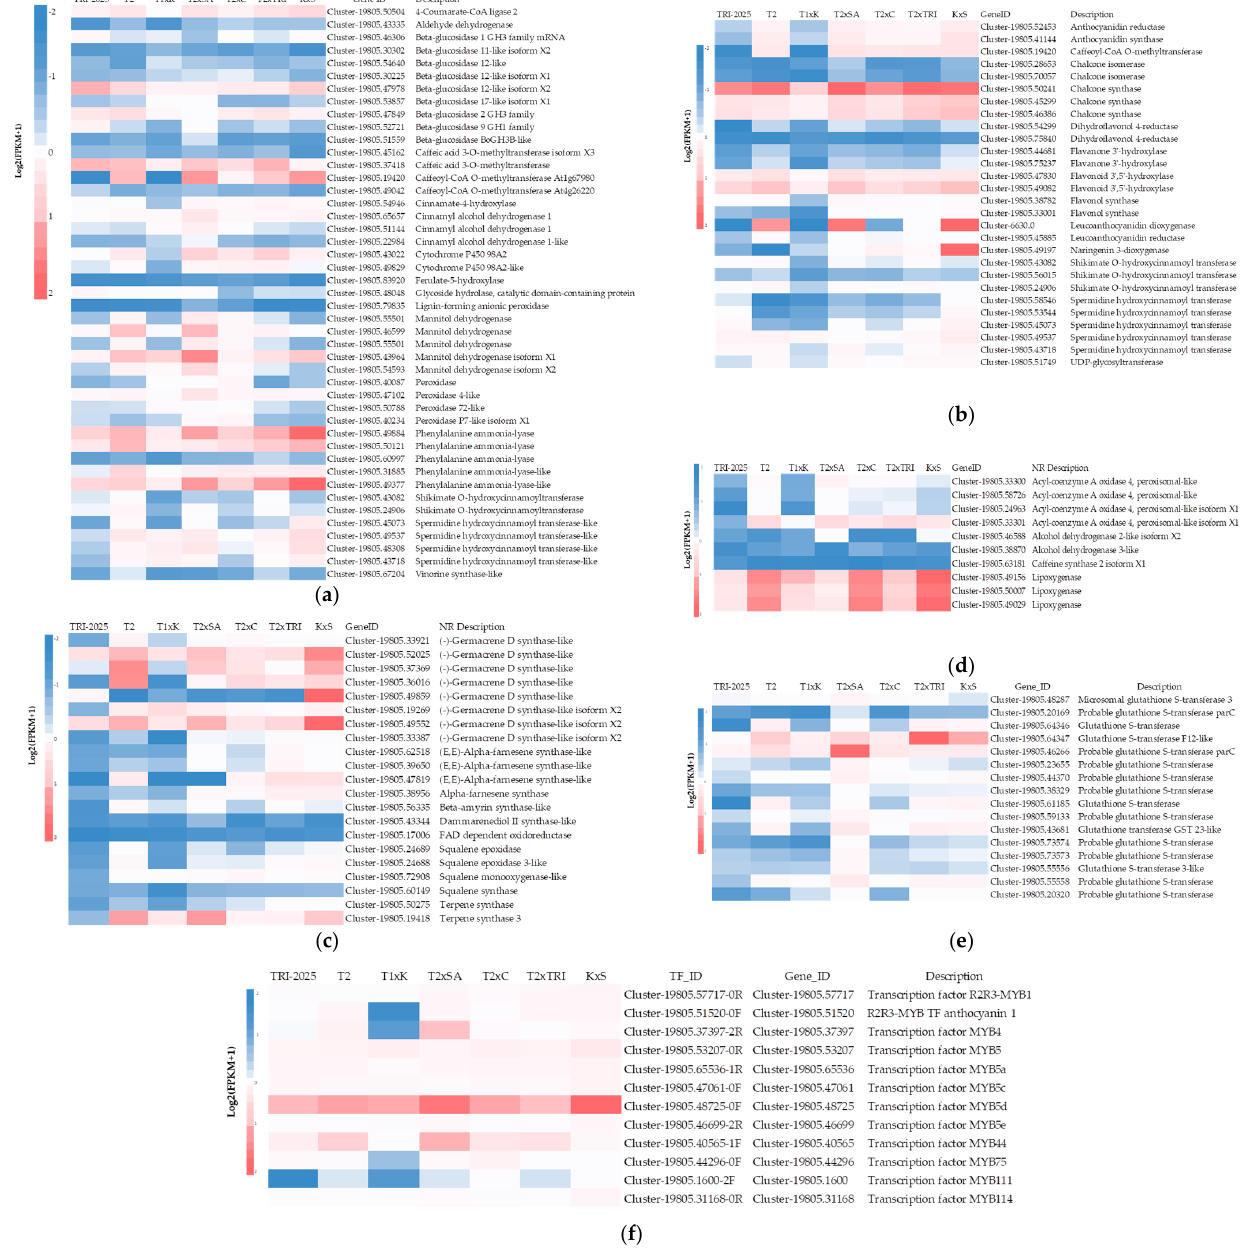
Figure 7. DEG enrichment analysis of each gene involved in biosynthesis and metabolism pathway that was associated with tea quality. ( a ) Phenylpropanoid biosynthesis; ( b ) flavonoid biosynthesis; ( c ) sesquiterpenoid and triterpenoid biosynthesis; ( d ) alpha-linolenic acid biosynthesis; ( e ) drug metabolism-cytochrome P450; ( f ) MYB TF. sized through a specific branch of a phenylpropanoid pathway [21]. Highly expressed alanine ammonia-lyase (PAL), 4-coumarate-CoA ligase 2 (4CL), beta-glucosidase-12 like isoform X2, caffeoyl-CoA O-methyltransferase At1g67980 (CCoAOMT), cinnamyl alco- hol dehydrogenase 1 (CAD1), cytochrome P450 98A2, mannitol dehydrogenase, caffeic acid 3-O-methyltransferase (COMT), cinnamate-4-hydroxylase (C4H), and spermidine hydroxycinnamoyl transferase (SHT), which have shown differences in the number of